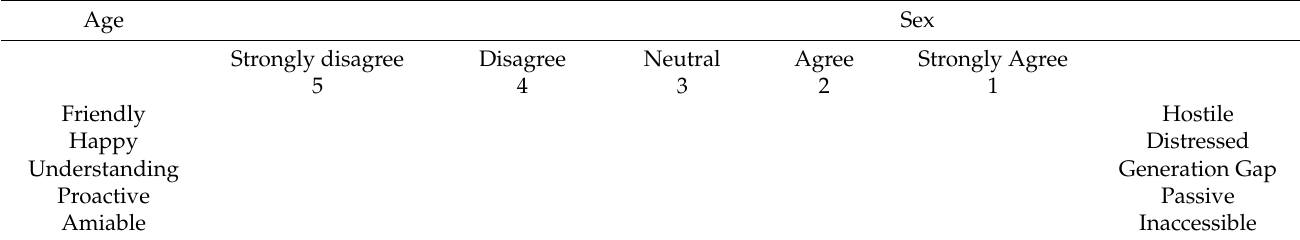
Table 1. Intergenerational Attitudes Scale.